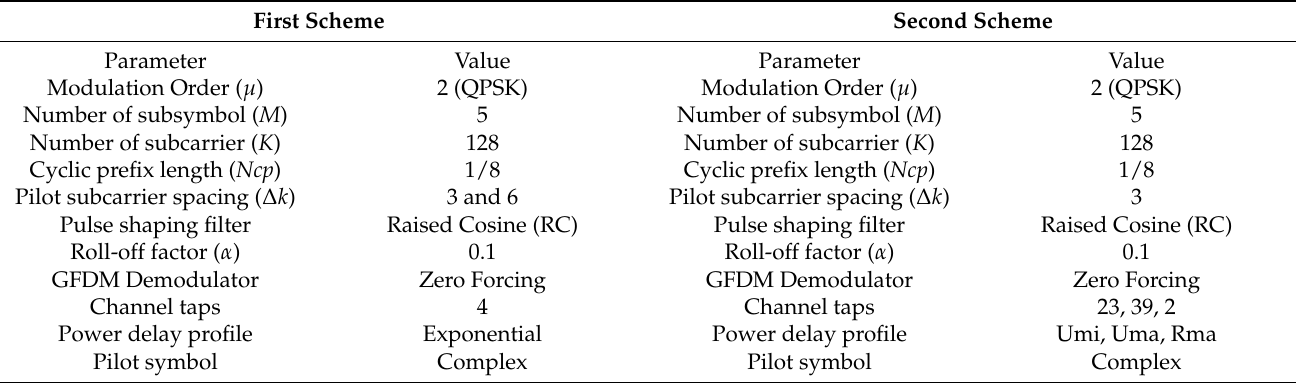
Table 3. Experimental setup parameters.